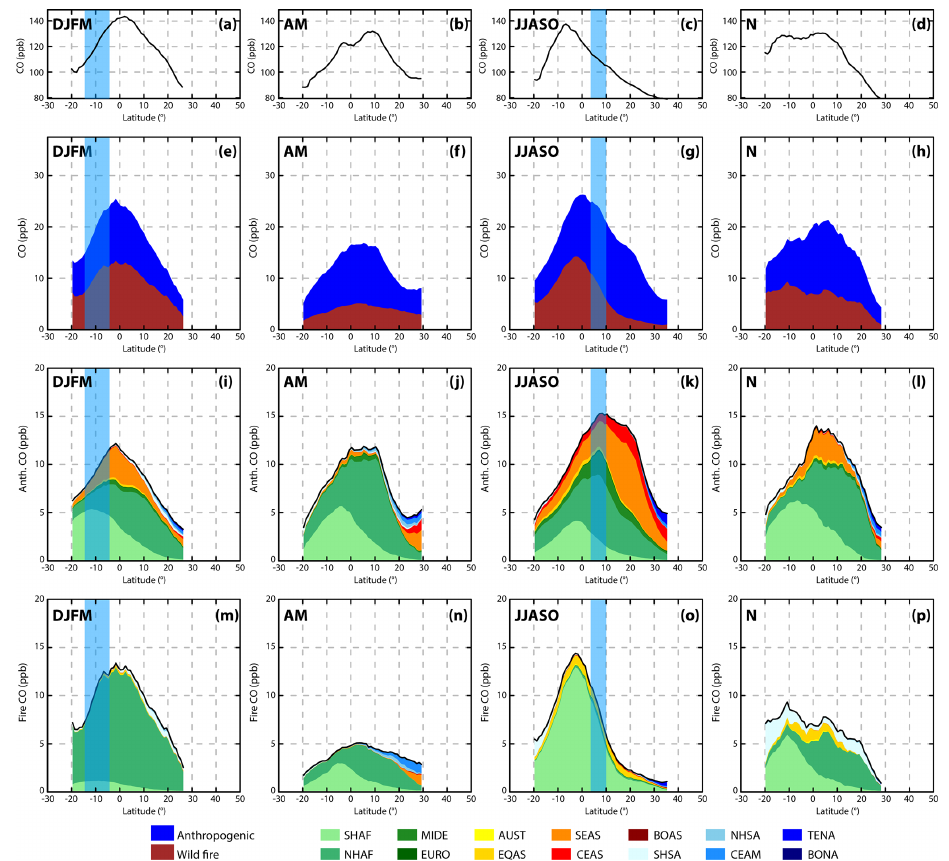
Figure 6. Meridional and seasonal transects of CO measured by IAGOS (a–d) , CO total anthropogenic and fire contributions calculated by SOFT-IO (e–h) , anthropogenic CO regional origins estimated with SOFT-IO (i–l) , and fire CO regional origins estimated with SOFT-IO (m–p) . The vertical blue rectangles represent the deduced ITCZ position. IAGOS and SOFT-IO data shown are averaged over all studied years (end